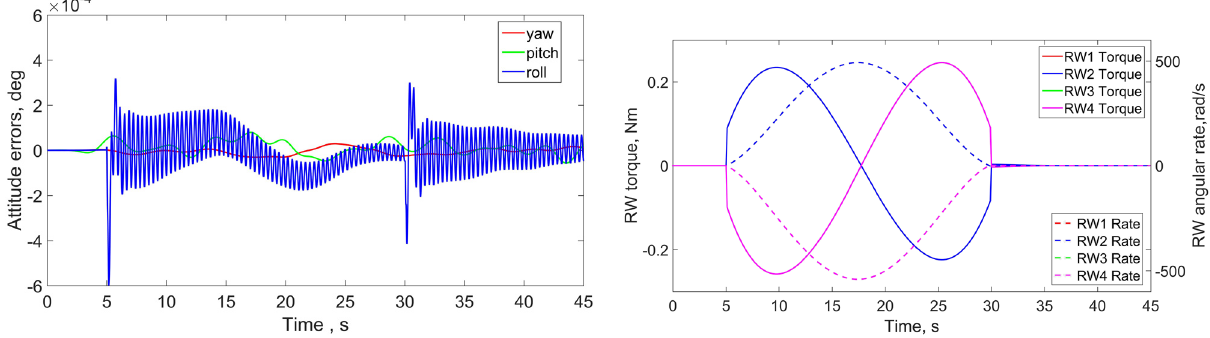
Figure 30: Angle attitude errors for case 3 ( w = 0.3 ) .